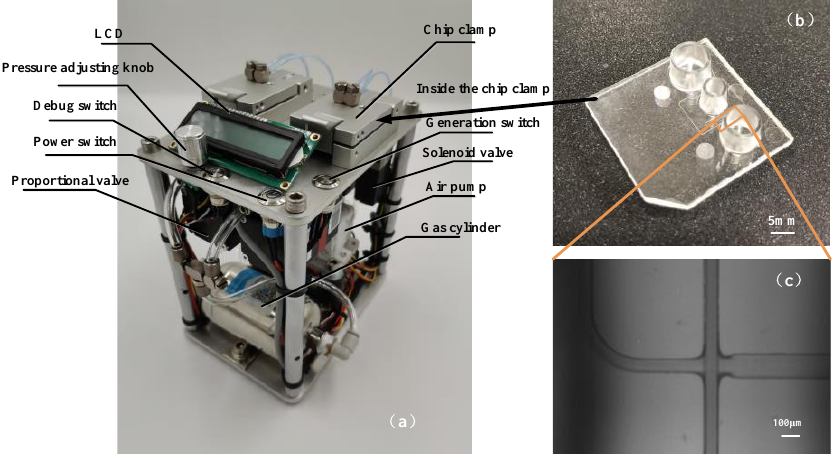
Figure 7. The integrated droplet generation platform for droplet digital polymerase chain reaction (ddPCR) ( a ). The microfluidic droplet generator ( b ). Micrograph Image of actual droplet generation junction ( c